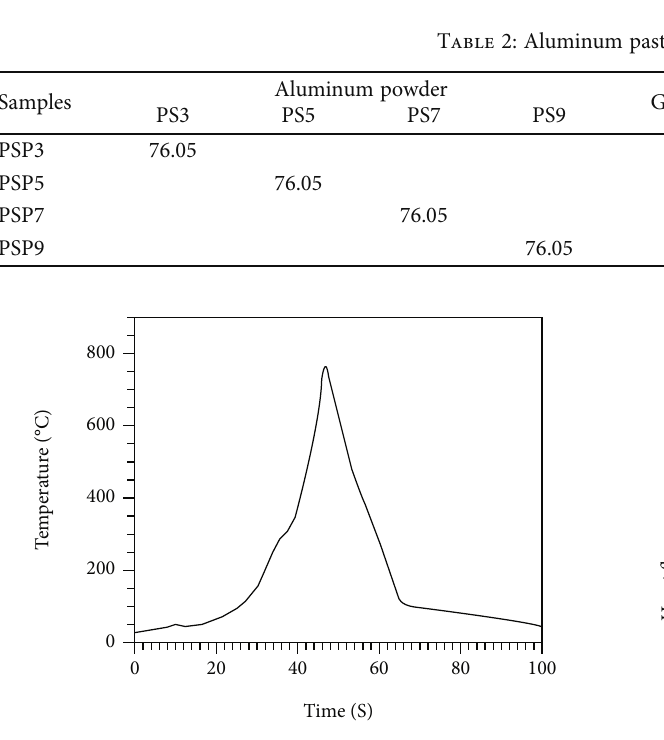
Figure 2: Sintering curve of sintering furnace.